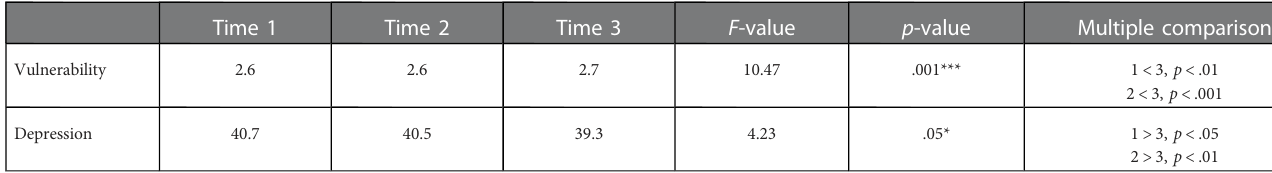
TABLE 1 Time-series basic data and results for vulnerability and depressive symptoms. Time